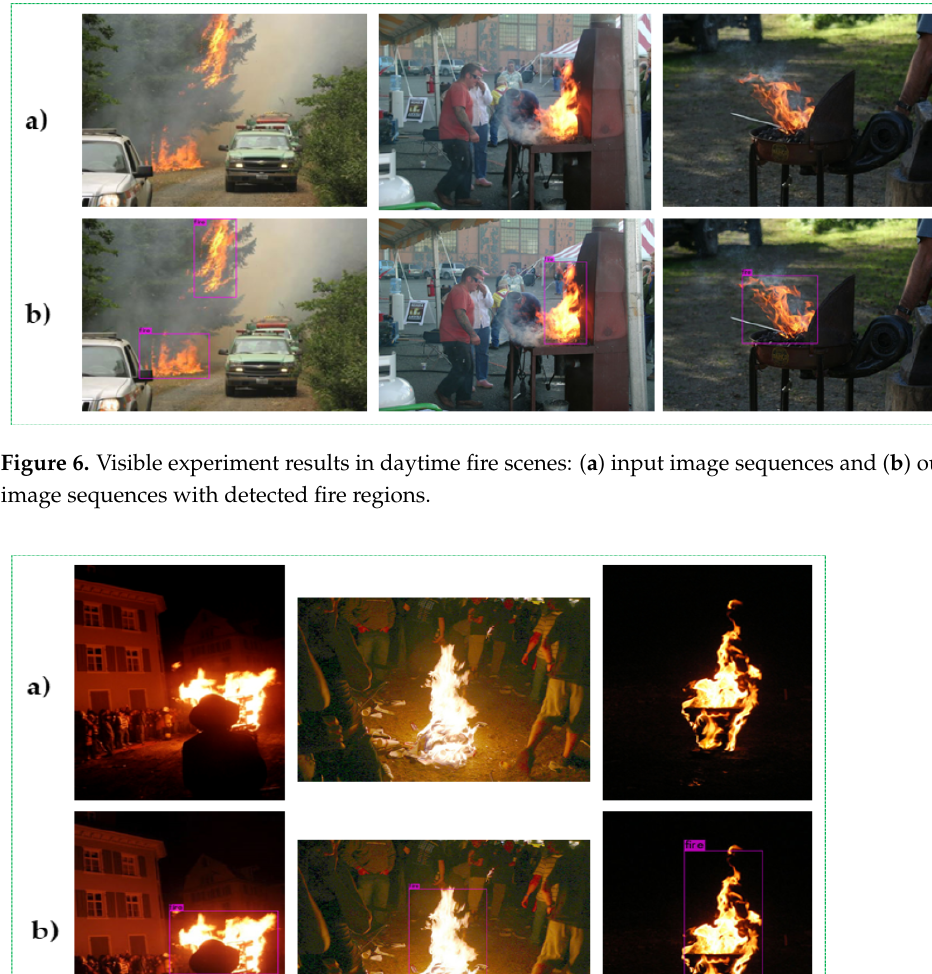
Figure 7. Visible experiment results in nighttime fire scenes: ( a ) input image sequences and ( b ) output image sequences with detected fire regions.